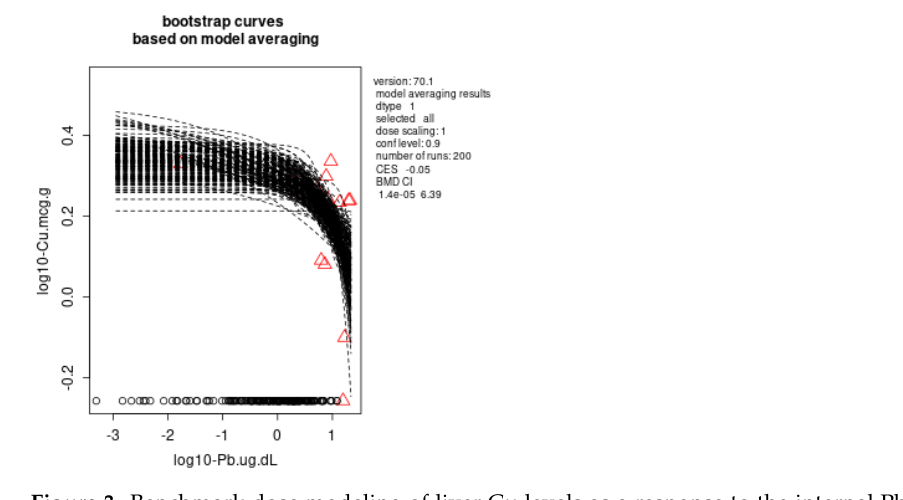
Figure 3. Benchmark dose modeling of liver Cu levels as a response to the internal Pb dose–BLL (µg/dL) using a model averaging method with 200 iterations, PROASTweb70.1 software (https://proastweb.rivm.nl/). The red triangles represent the medians.